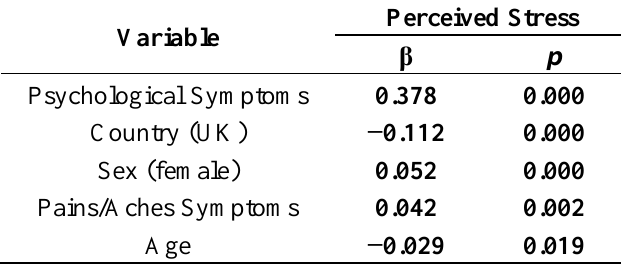
Bolded cells indicate statistical